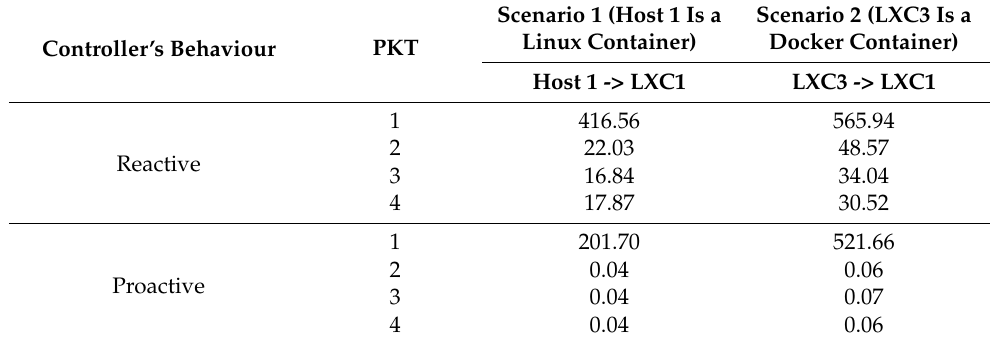
Table 3. Delay performance tests comparison, with 4 ICMP packets (values in ms obtained from